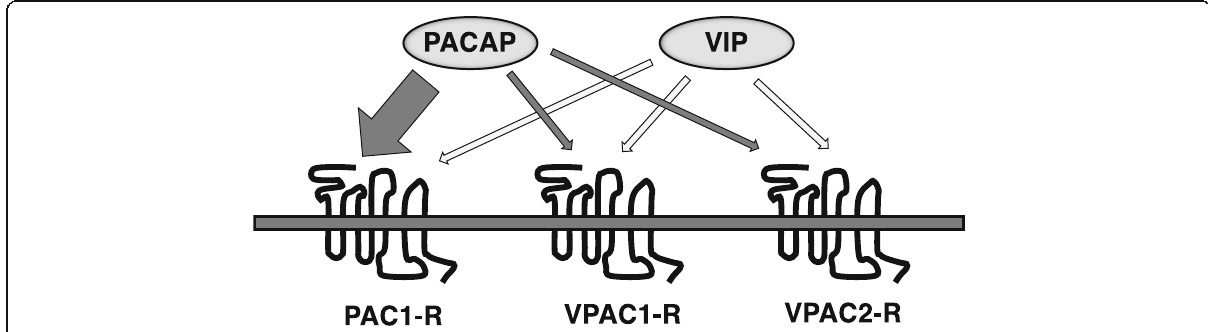
Fig. 1 Comparison of the receptor affinity of PACAP and VIP. PACAP shows a>1000-times higher affinity for PAC1-R than VPAC1-R or VPAC2-R [5 –